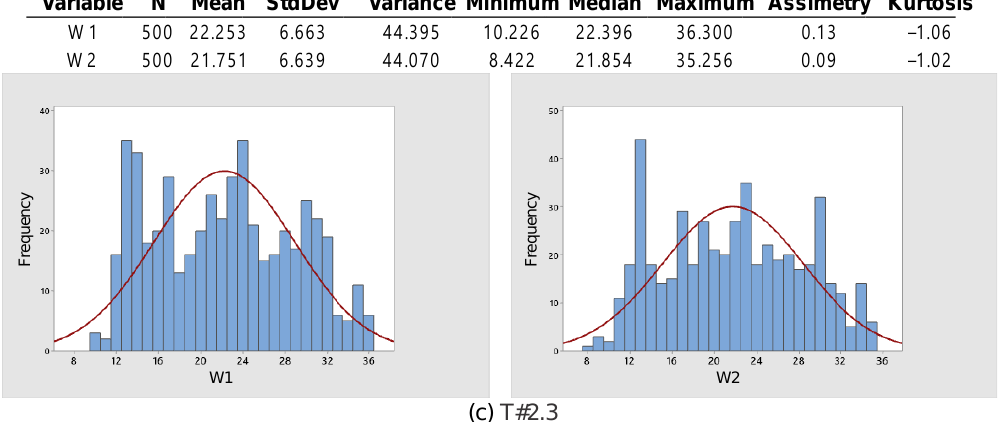
Figure 21. Basic descriptive statistics applied to data obtained during the trial sessions carried out on firm soil with the slip manually controlled by the